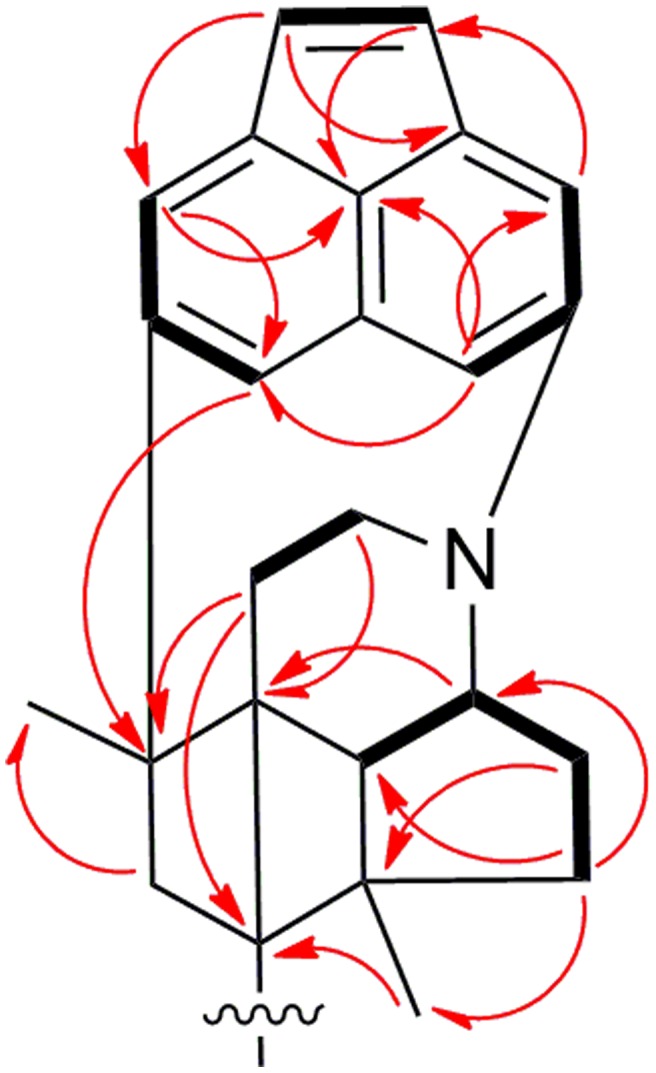
Selected 1H-1H COSY (bold lines) and HMBC (red arrows) correlations of xinghaiamine A.